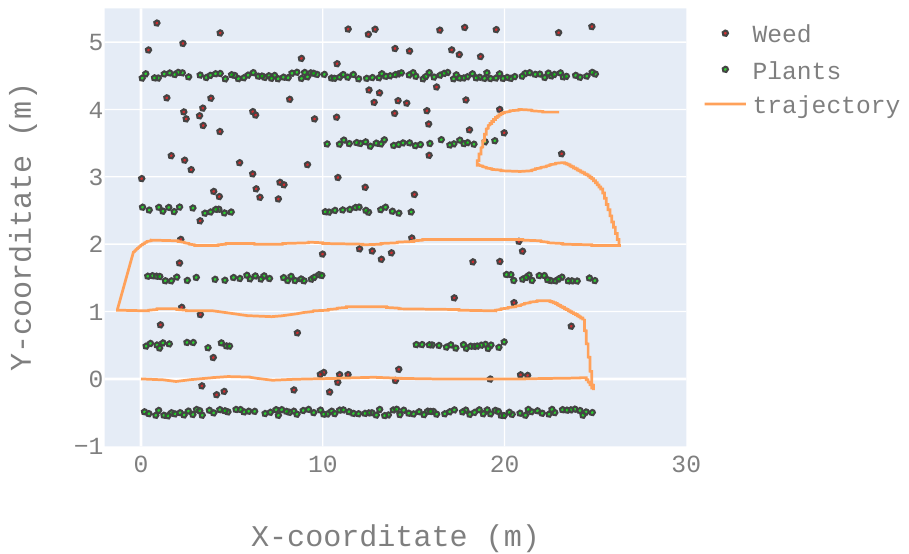
Figure 16. An example of a failed trajectory: the robot reaches the end of the fifth row but runs over the crop